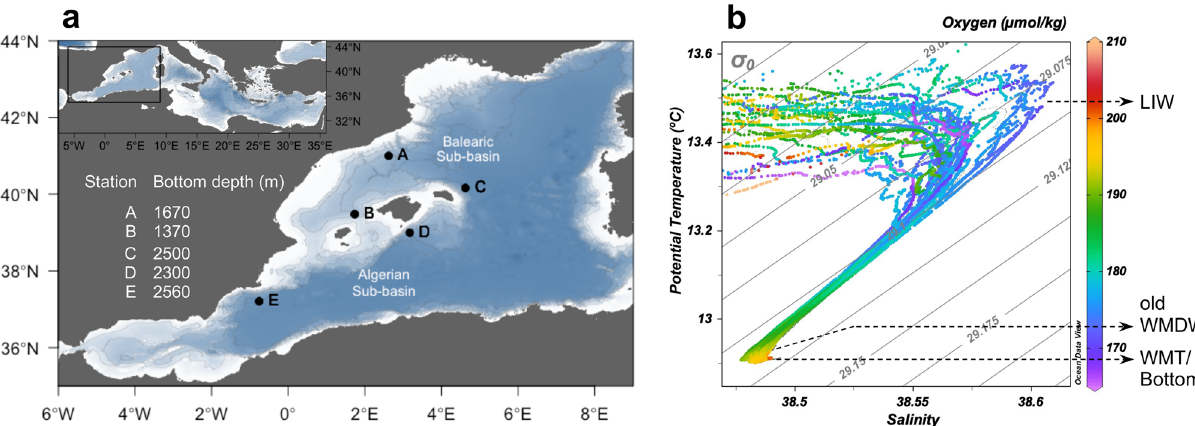
Figure 1. Sampling locations and depths across the western basin of the Mediterranean Sea. ( a ) Map of sampling stations (labelled black dots). The bottom depth is indicated for each station. Coastline and bathymetry from NOAA database (https:// www. noaa. gov), using the ‘marmap’ package of R. ( b ) Potential temperature— salinity diagram (T–S) of all stations and cruises, colour scale corresponds to oxygen concentration (µmol kg −1 ). The water masses sampled are indicated: Levantine intermediate water (LIW), old western Mediterranean deep water (old WMDW) and Western Mediterranean Transition or bottom